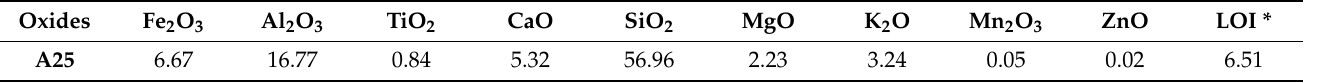
Table 1. Chemical composition (percentage weight: wt%) of the natural clay